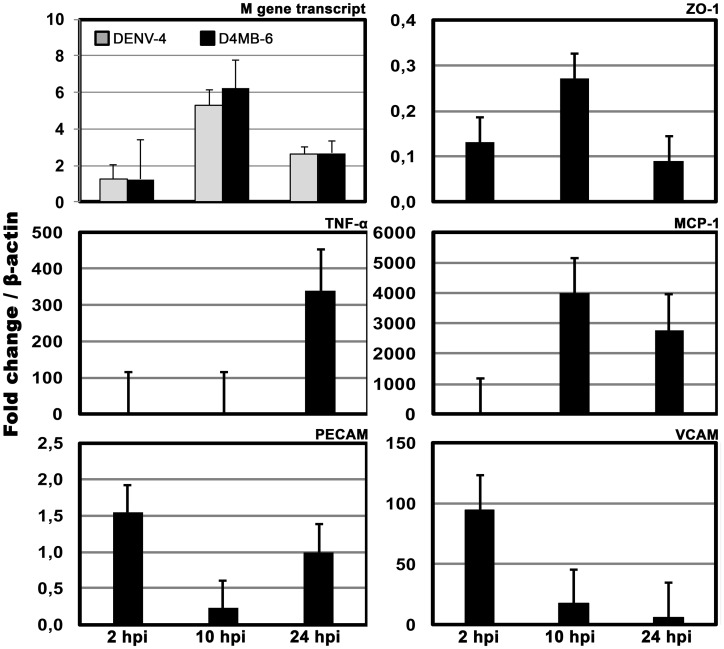
RNA quantitation of viruses, cell proteins, inflammatory mediators and adhesion molecules.MBECs were infected with D4MB-6 and then processed to amplify a segment of dengue M protein gene, and cellular transcripts to ZO-1, TNF-α, MCP-1, PECAM, and VCAM using a quantitative RT-PCR. There were no significant changes in the amount of viral RNA and ZO-1 expression in the evaluated time points. TNF-α transcription was increased at 24 h p.i., while MCP-1 expression was increased at 10 h p.i. PECAM transcription increased at 2 and 24 h p.i. but not at 10 h p.i., while, VCAM expression was increased early (2 h p.i) and then gradually decreased over time. The data are shown as the relative expression obtained from duplicates of two independent experiments. The data were analyzed using the methods described in Pffafl et al [23] or Schefe et al, [24].